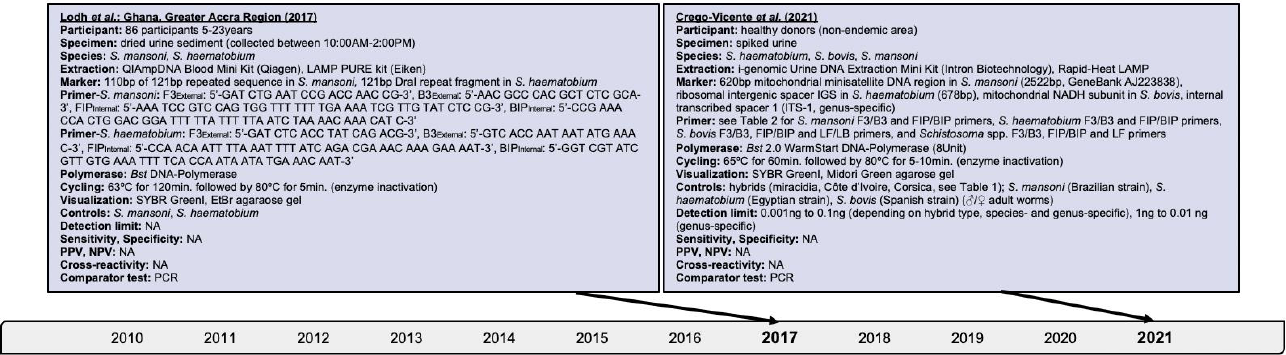
Figure 5. Articles identified on the isothermal diagnosis of mixed Schistosoma infections with details on participants, specimens, assay features, and test evaluation in terms of detection limits, sensitivity, specificity, PPV and NPV versus a comparator test by chronological order of publication date. Articles highlighted in light blue delineate schistosomal diagnosis based on loop-mediated isothermal amplification (LAMP). We searched databases of PubMed, Embase and Web of Science for suit- able publications on the isothermal diagnosis of schistosomiasis among clinical specimens collected from human subjects by applying the following terms: “schistosomiasis”, “Schistosoma”, “snail fe- ver”, “ schistosomiasis MeSH Terms ” , ”isothermal”, “diagnosis/diagnostic”, “detection”, and “as- s ay” . The last searches were performed on 31 December 2021. Publications included after removing duplicates, screening titles and abstracts, reading full-texts, and complementing through reference searches were not restricted by time period, but by the availability of full-texts available in English.